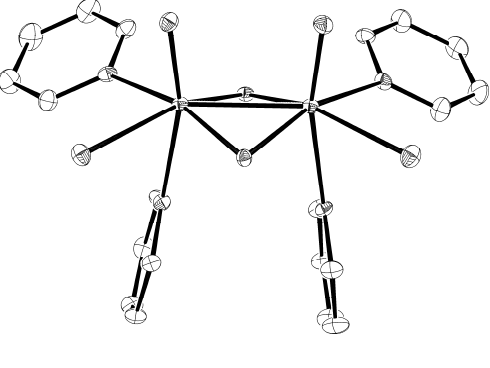
O Cl (Py) ] molecule in 2 . Atoms are 2 4 2 4